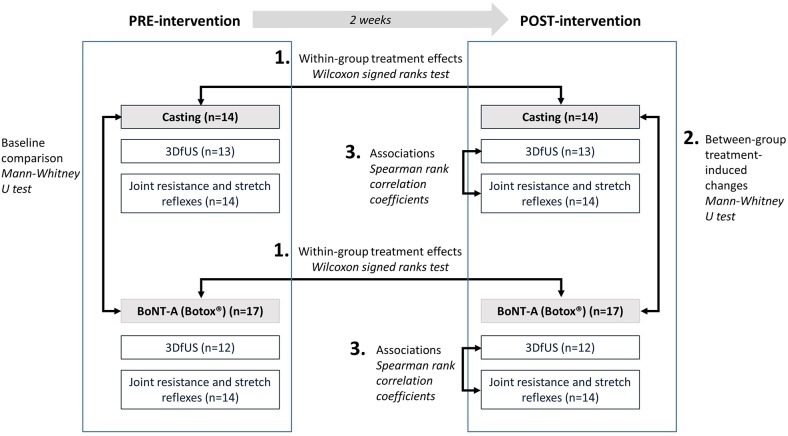
Flowchart of the inclusion of participants with an overview of the available and missing data. 3DfUS, 3D freehand ultrasound; GMFCS, gross motor functional classification scale; BoNT-A, Botulinum NeuroToxin-A.